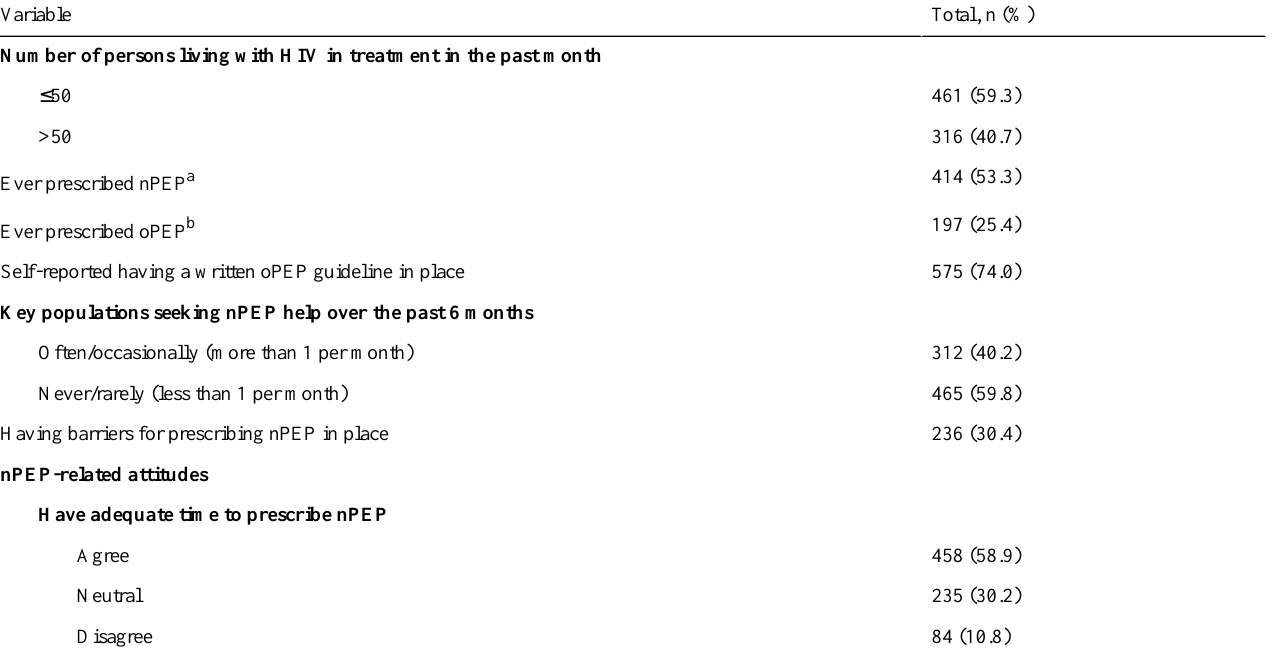
Table 2. Experiences and attitudes among HIV medical care providers in China